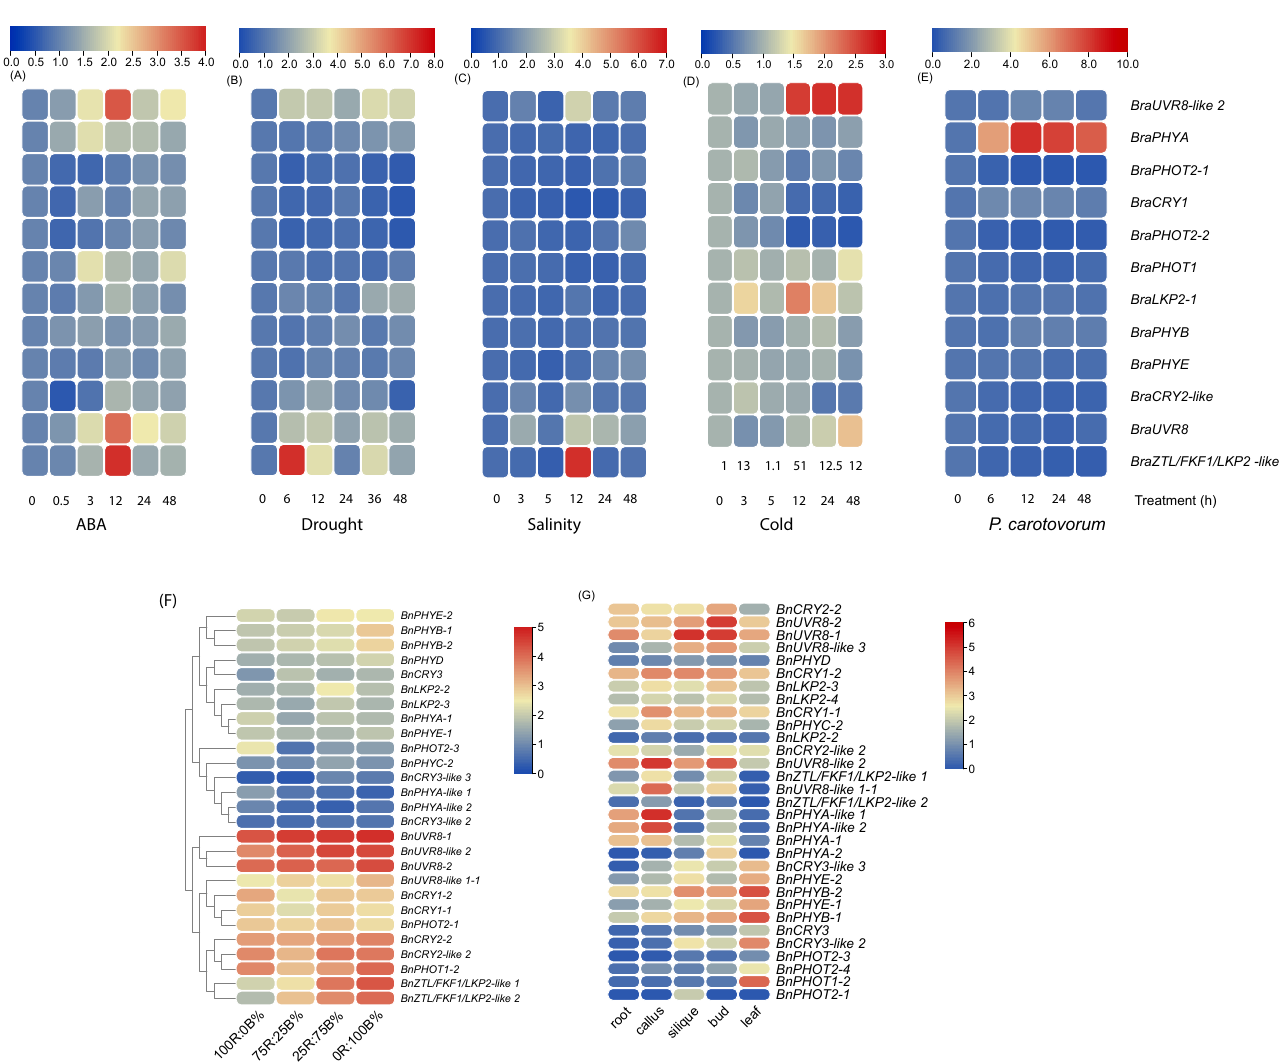
was consistently downregulated under ABA